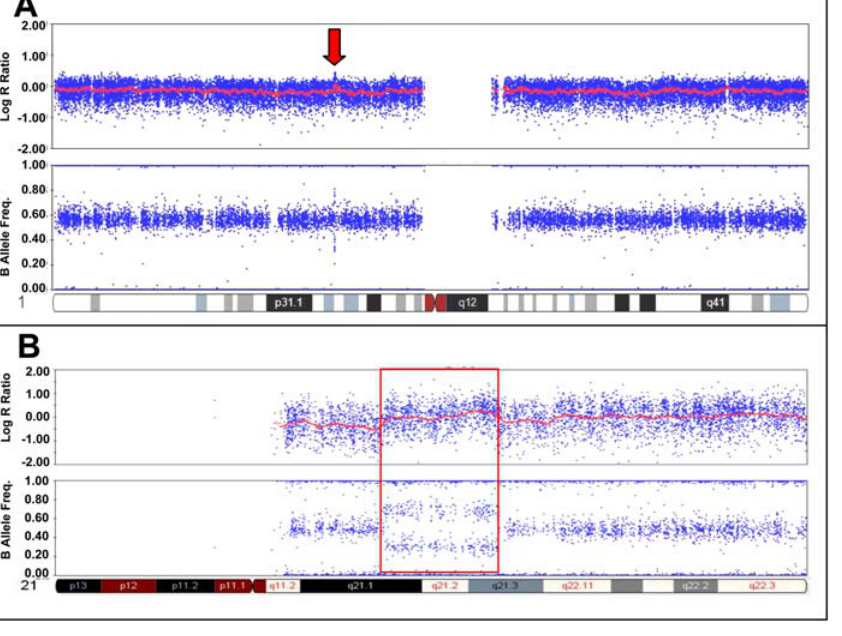
Figure 2. Log R Ratio and B Allele plots for Two Samples Showing Genomic Duplication Genomic duplication is indicated by an increase in log R ratio and B allele frequency clusters outside of the expected values of 1 (B/B), 0.5 (A/B), and 0 (A/A). (A) Shows duplication of a small segment on Chromosome 1 (red arrow). (B) Shows duplication of a region of approximately 7 Mb on Chromosome 21, outlined in red. This region contains APP, and the duplication mutation results in a neurodegenerative phenotype (courtesy of J.